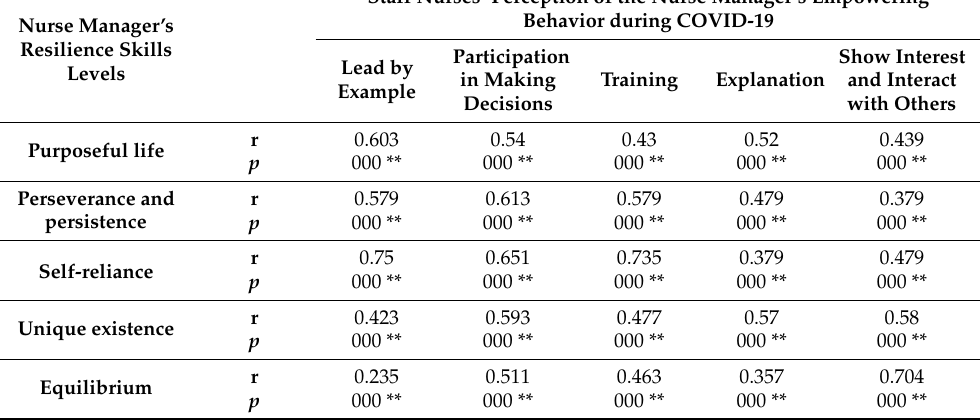
Table 5. Correlation between nurse manager’s resilience skills levels and staff nurses’ perception of their empowering behavior level during